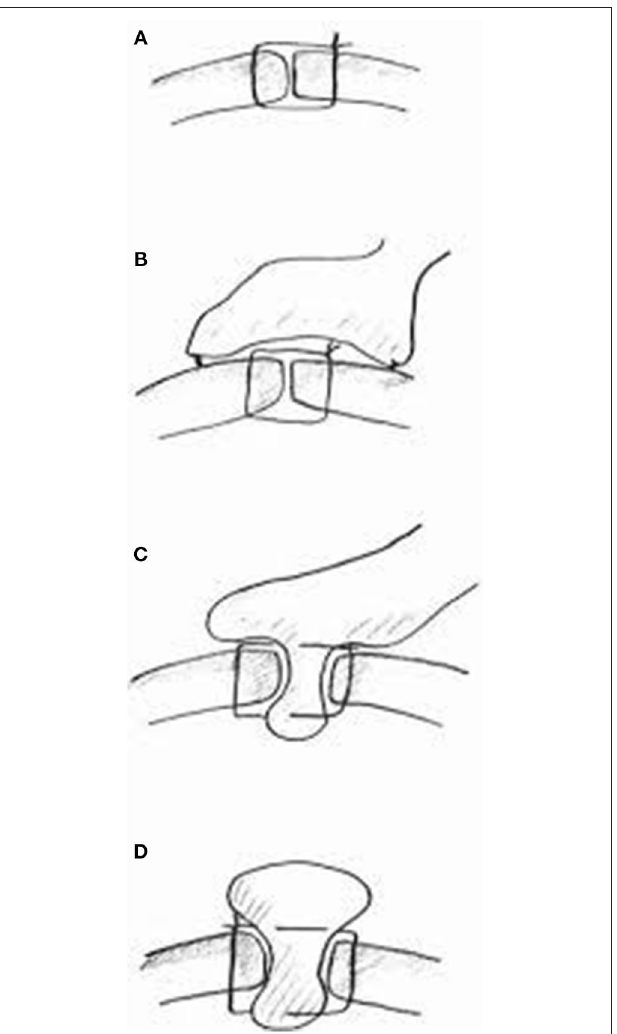
FIGURE 1 | Summary of different suture techniques for closure of perforation [From above: (A) primary closure by interrupted sutures, (B) primary closure by interrupted sutures covered with pedicled omentopexy, (C) Cellan-Jones repair-plugging the perforation with pedicled omentoplasty, (D) Graham patch-plugging the perforation with free omental plug; with permission Bertleff and Lange (1)].